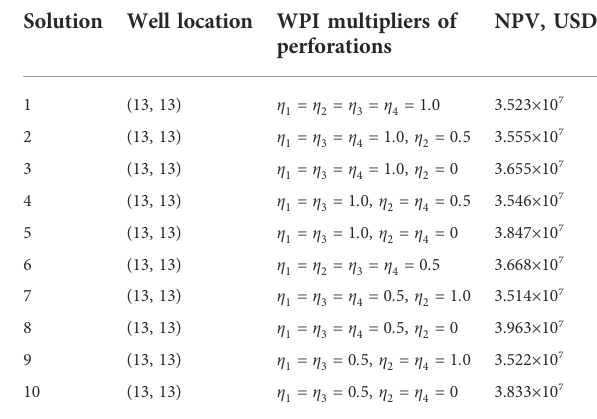
TABLE 3 NPV for some possible well